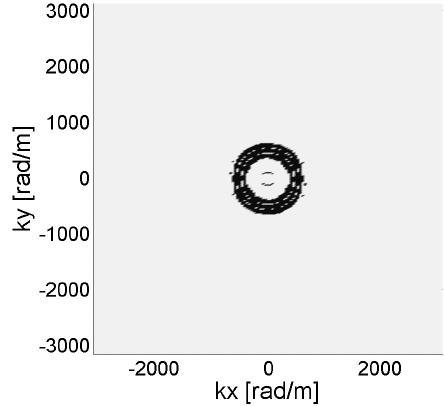
Figure 4. Adaptive filter mask in the wavenumber-wavenumber domain.